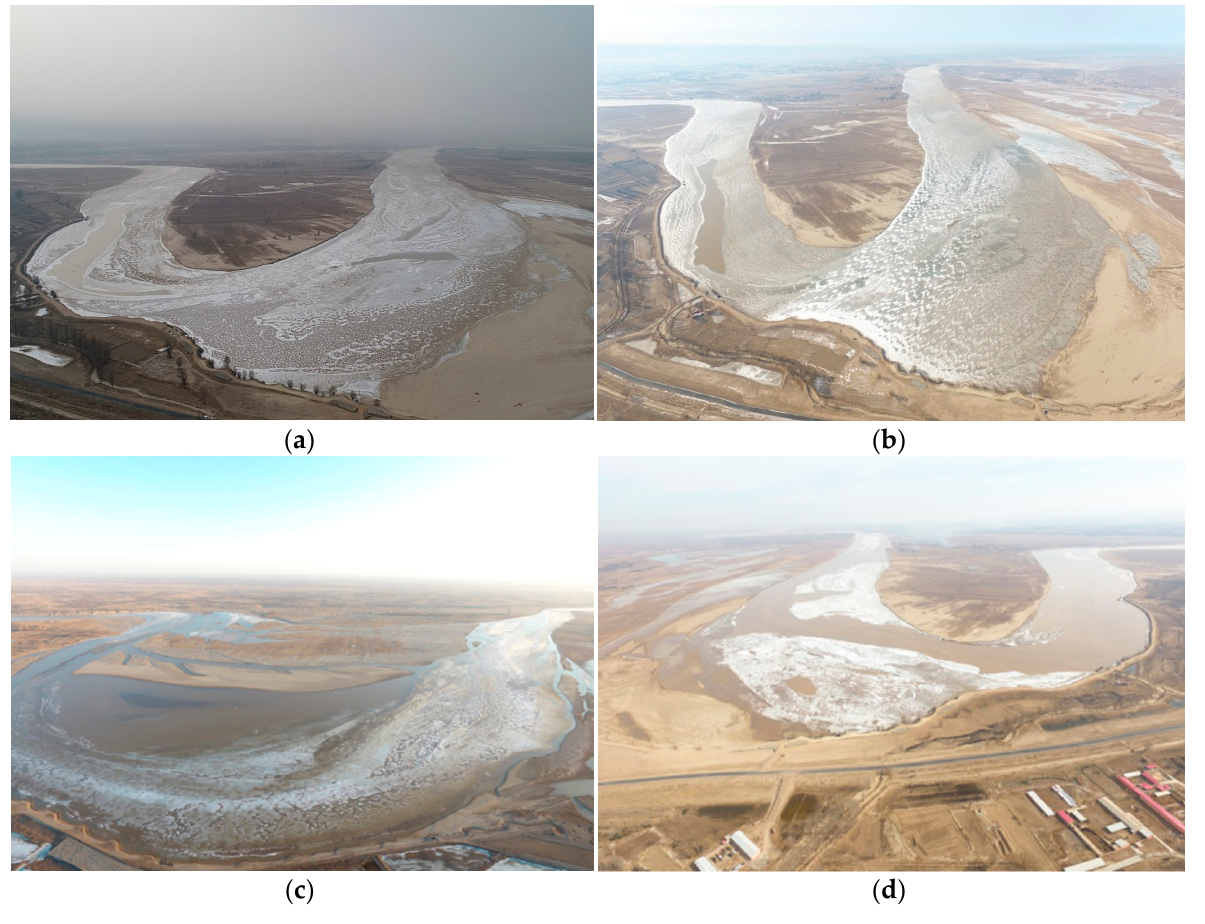
Figure 13. Aerial photographs of the ice generation and disappearance process in the Shisifenzi section during the ice period: ( a ) Ice accumulation and frozen river; ( b ) stable river freeze-up; ( c ) temperature rise and ice cover melting; ( d ) ice breakup and river opening.